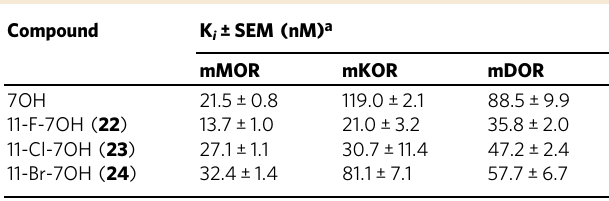
Table 1 Binding af fi nities of 7OH analogs at the mouse opioid